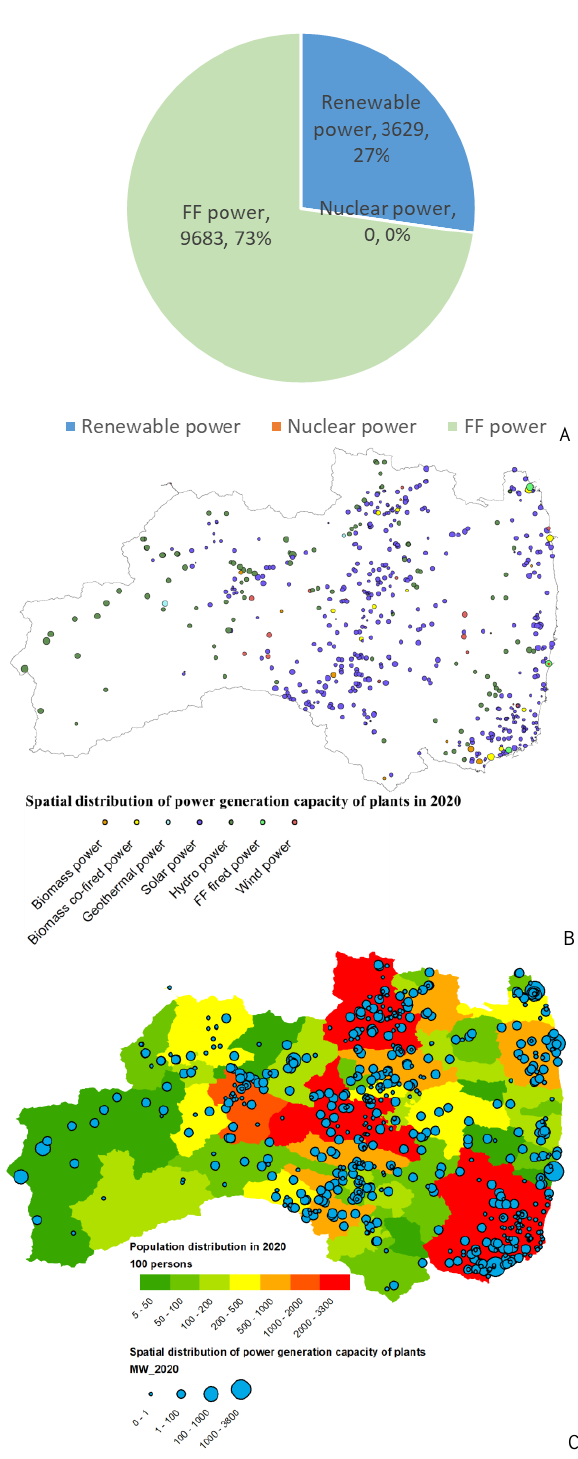
Figure 4. The condition of the electricity supply in 2020, Fukushima Prefecture: (A), the proportion of the total generation capacity by facility types (unit: MW and %).